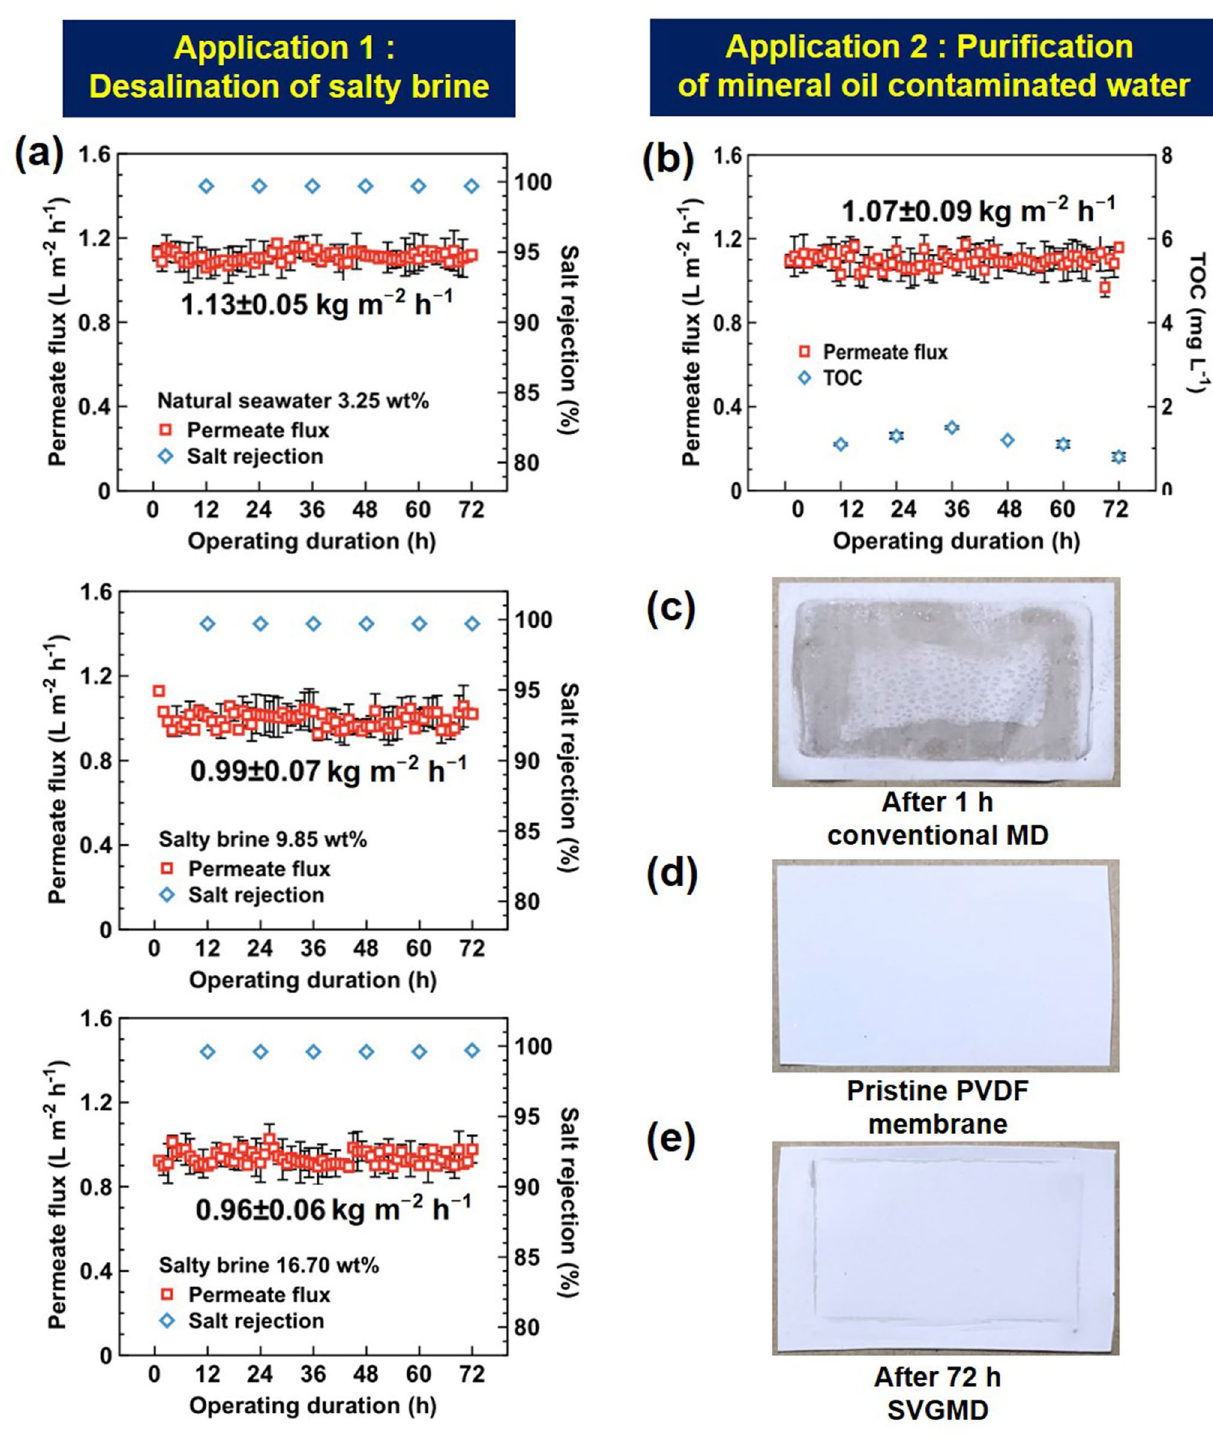
Fig. 4 Two main applications for long-term, effective desalination and purification. a The permeate flux and salt rejection of SVGMD for natu- ral seawater (3.25 wt%) and two kinds of salty brine (9.85 and 16.70 wt%) at an illumination of 1 kW m −2 . b The permeate flux and TOC level of purified water of SVGMD when processing mineral oil-contaminated water at an illumination of 1 kW m −2 . c – e Optical images of PVDF membrane c , after processing mineral oil-contaminated water in the conventional MD over 1 h ( d ) and in the SVGMD system over 72 h ( e ). The error bar comes from three repeated tests. All tests were performed at a room temperature and atmospheric